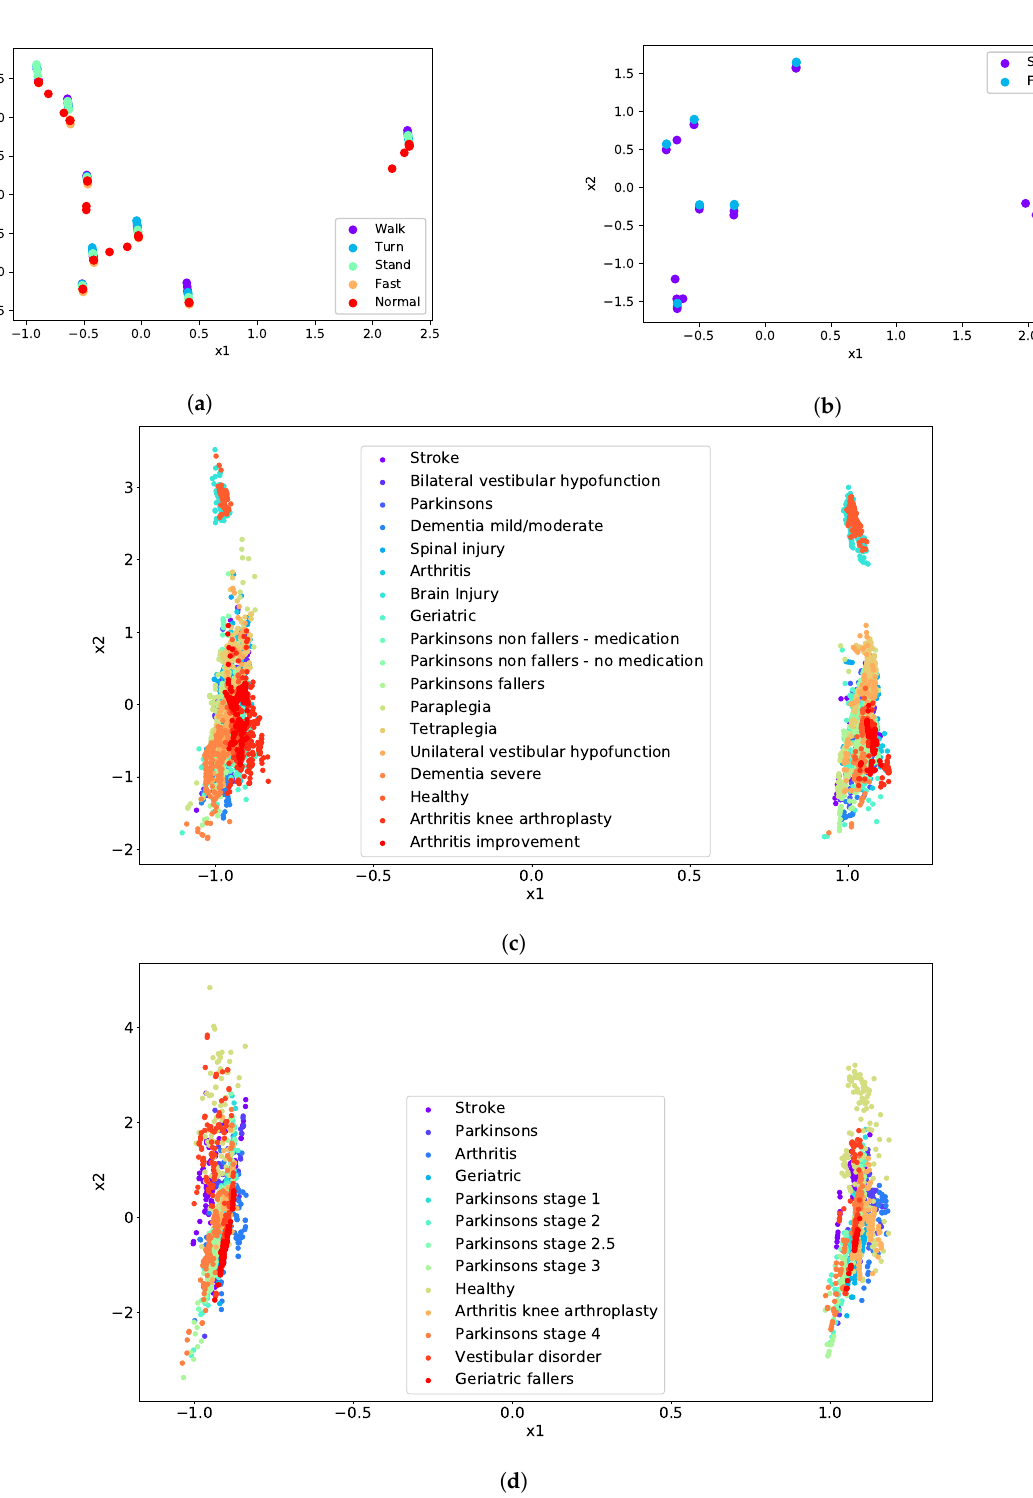
Figure 2. ( a ) Principal component analysis biplots for TUG experiment data, reducing the features to 2, ( b ) FTSTS experiment, ( c ) TUG synthetic, and ( d ) FTSTS